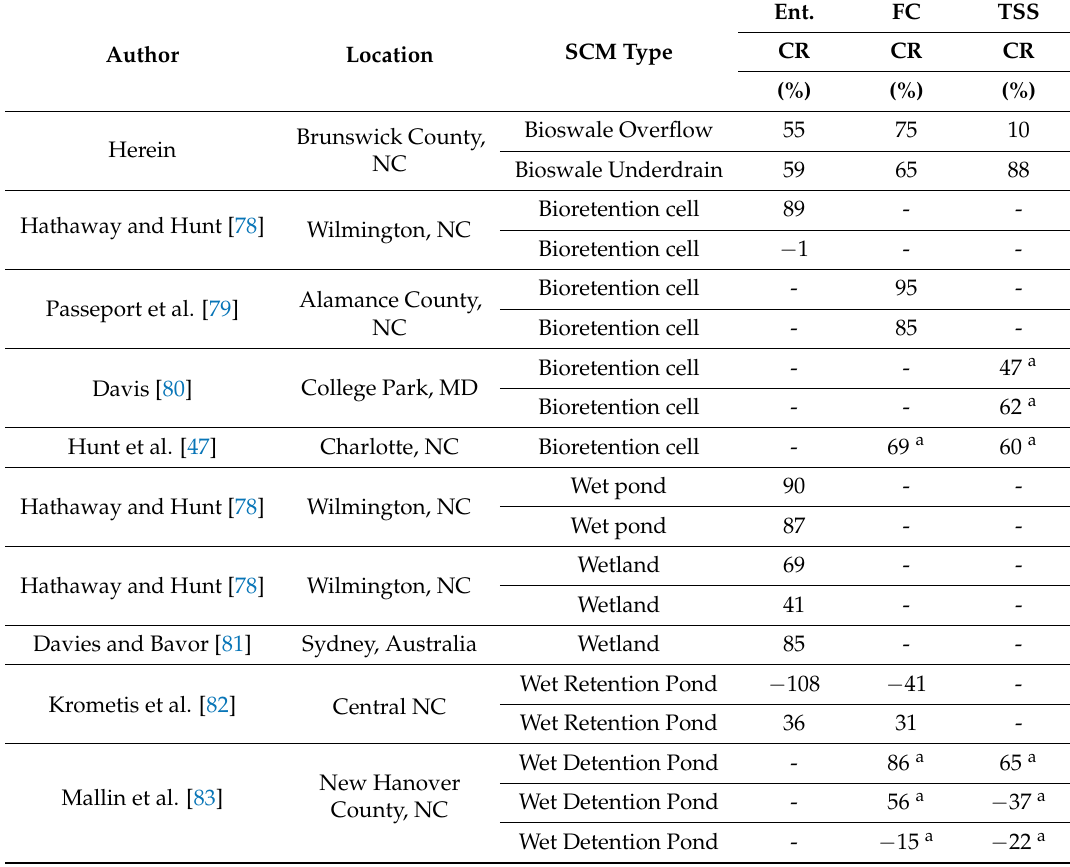
Table 6. Summary of studies reporting bacteria and sediment concentration reductions from